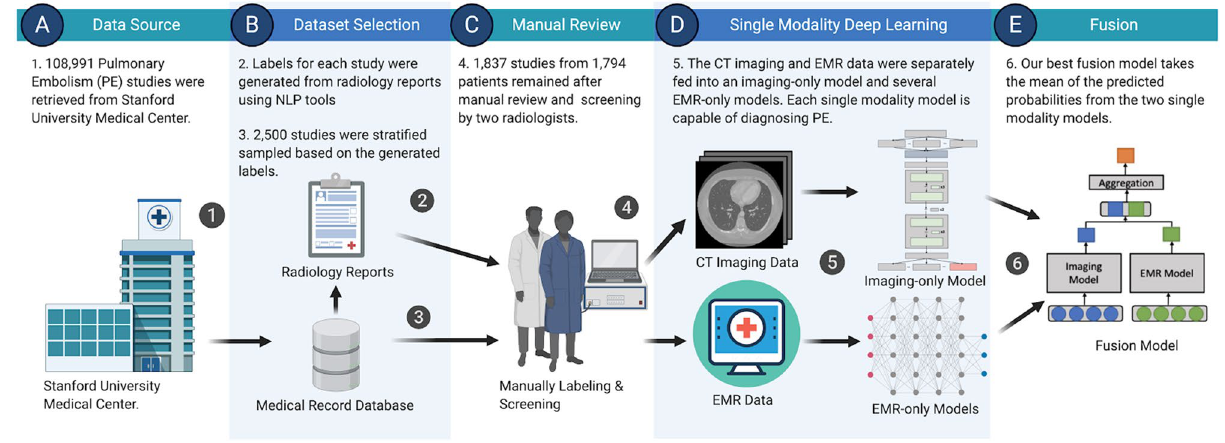
Figure 1. Overview of the workflow for this study. We extracted a total of 108,991 studies from Stanford University Medical Center ( A ) and sampled a subset ( B ) for manual review ( C ). 1837 studies remained after screening by two radiologists and were used to train and evaluate our models. Single modality models were created ( D ) both as baselines for comparisons as well as components for the fusion models ( E